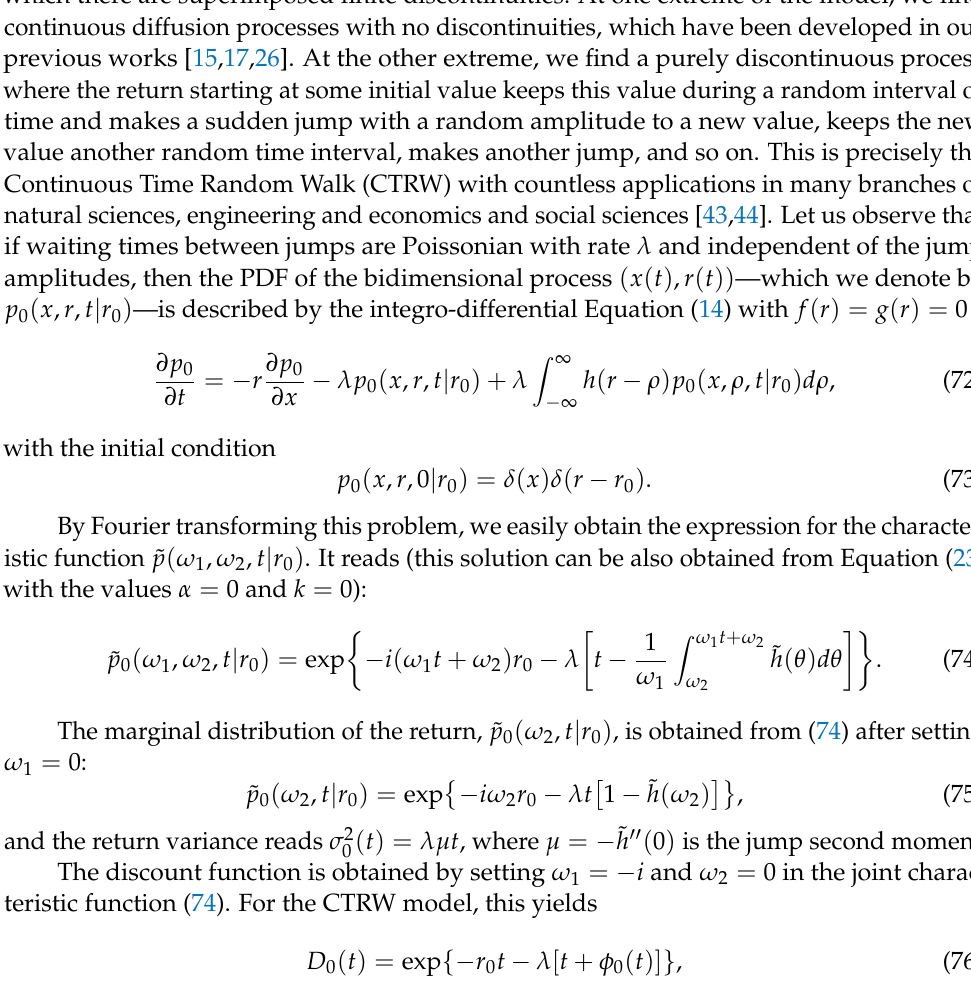
Figure 4. Critical time as a function of the Laplacian jumps amplitude c = γ / ( (cf. Equation (70)) and for several values of ˆ α attributed to different countries. We take the Ornstein–Uhlenbeck ˆ α parameter estimated somewhere else [17]: 1/ ( 6.068 years ) for Netherlands (NED), 1/ ( 16.58 years ) for United States of America (USA), 1/ ( 70.42 years ) for Canada (CAN), and 1/ ( 188.7 years ) for Japan (JAP). The inset shows in further detail the cases with shorter critical